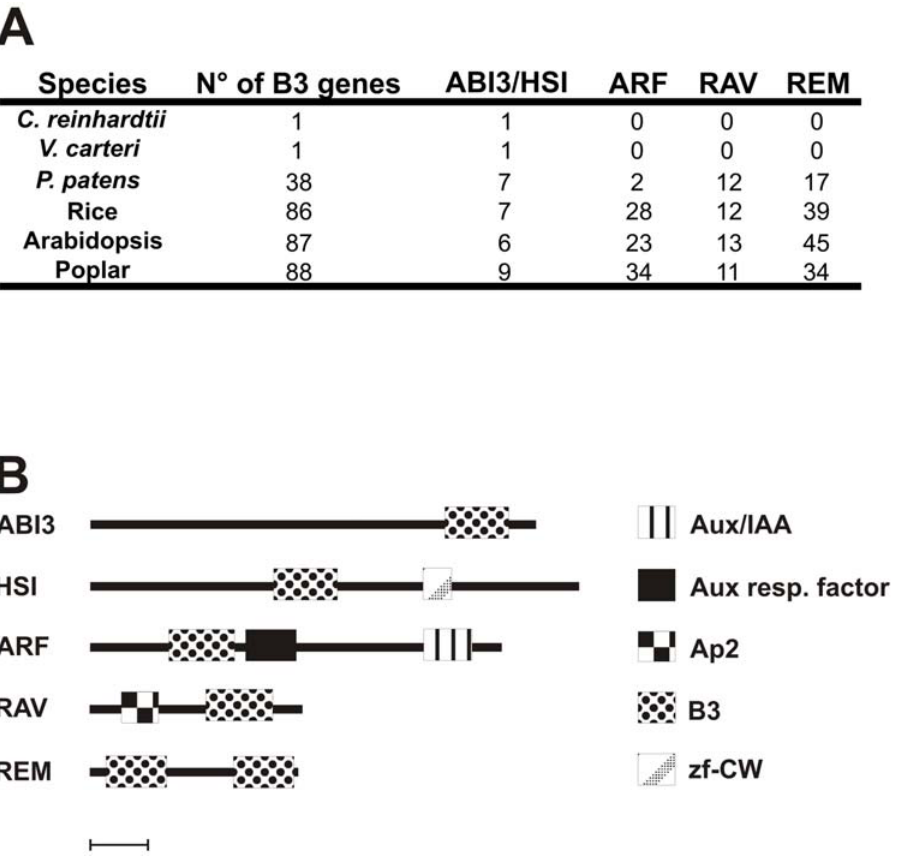
Figure 1. Table with total number of B3 protein per species and diagram of domain organization of the B3 family based on their protein sequences. A – The identification of all proteins containing the B3 domain was conducted using the INTERPRO code of the B3 in respective species web site. Complete information of the genes and domains are in tables S1, S2, S3 and S4. B – Diagram of the domains organization of selected B3 proteins of each family. All selected proteins are from Arabidopsis, contain the typical domains found in each respective family and have been studied before: ABI3, At3g24650 (ABI3); HSI, At2g30470 (HSI2/VAL); ARF, At1g59750 (ARF1); RAV, At1g13260 (RAV1); REM, At3g18990 (VRN1). Proteins of REM family have one to 11 B3 domains. The domains are shown in scale and solid lines denote protein sequences. Bar – 100 amino acids.